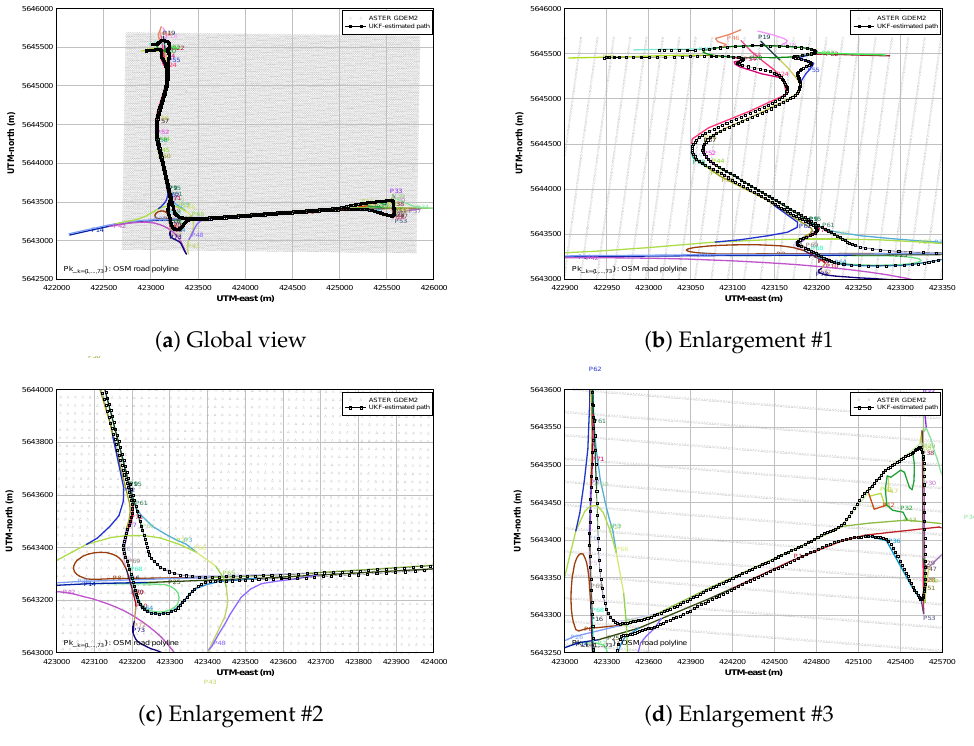
Figure 5. Estimated path of the vehicle vs. OSM road